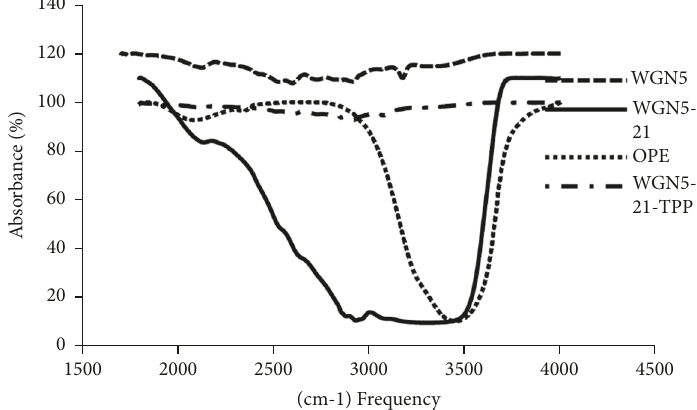
Figure 1: ATR-FTIR spectra of WGN5, WGN5-21, OPE extract and WGN5-4.2-TPP film